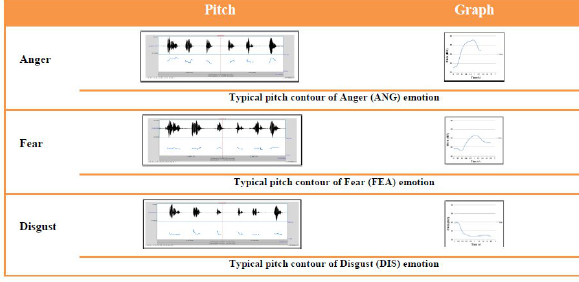
Fig. 11. American pitch contours for Anger, Fear and Disgust.